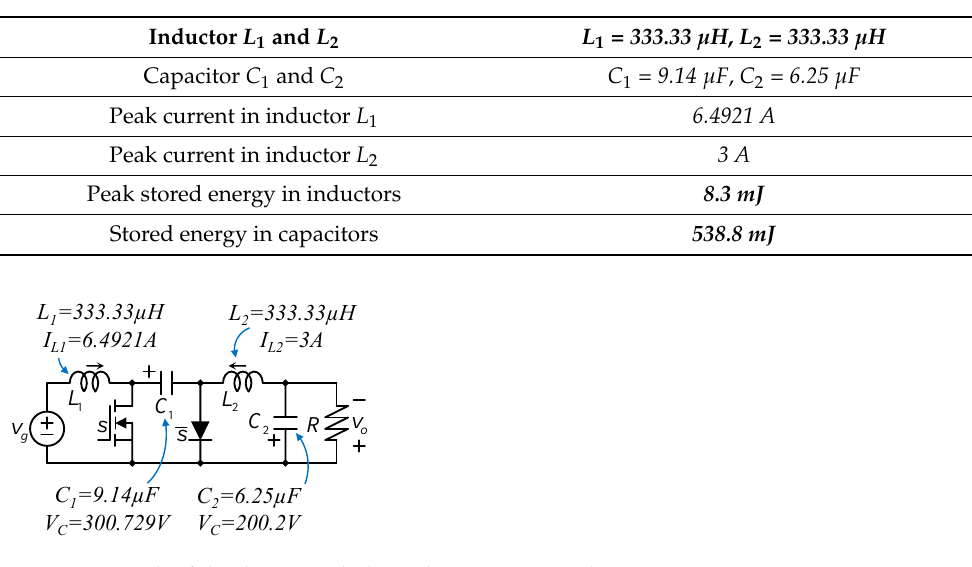
Table 5. SEPIC converter results.